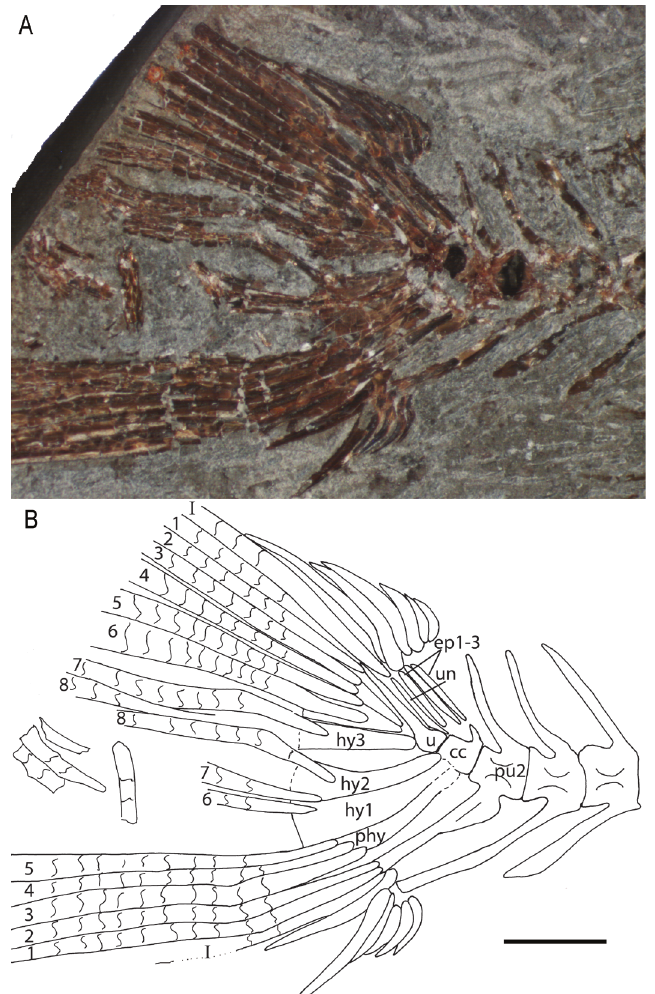
Figure 4. Cumbaaichthys oxyrhynchus gen. et sp. nov., UALVP 56113. A, Photograph of the caudal skeleton under polarized light; B, interpretive drawing and indication of principal fin ray count. Scale bar equals 2